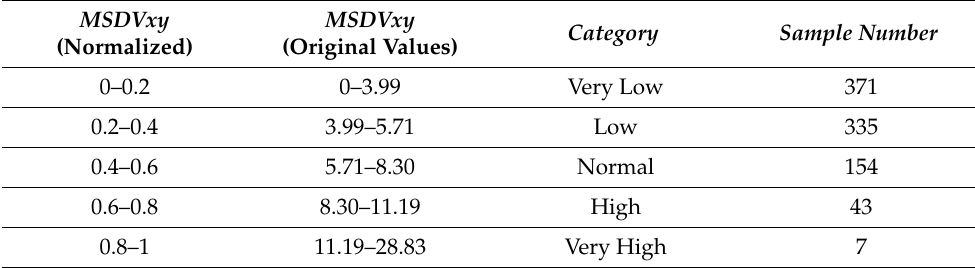
Table 3. Categorization divisions and the original values of the utilized